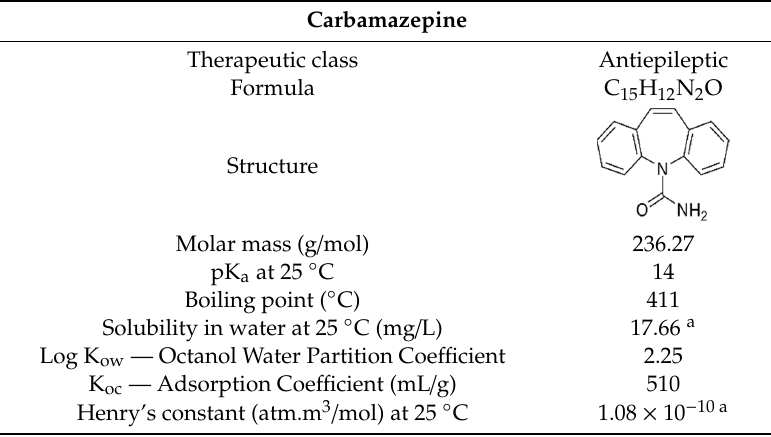
Table 1. Therapeutic use and physicochemical properties of carbamazepine.